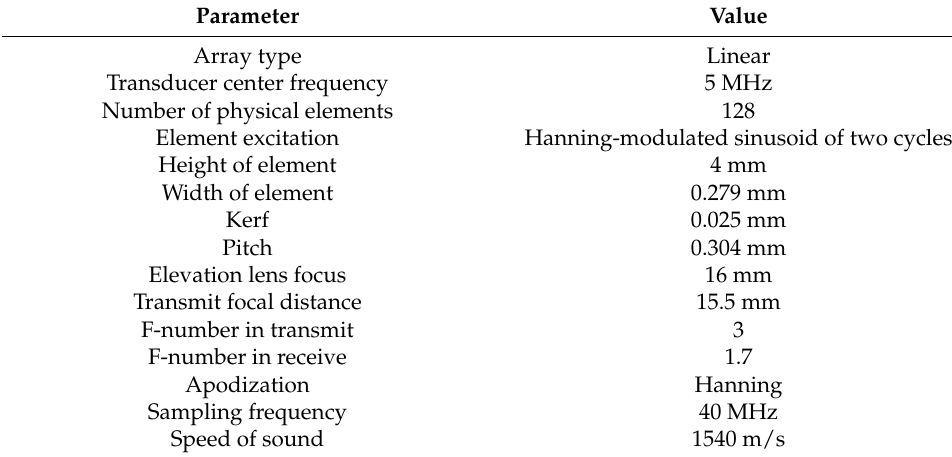
Table 1. Parameters of virtual scanning with Field